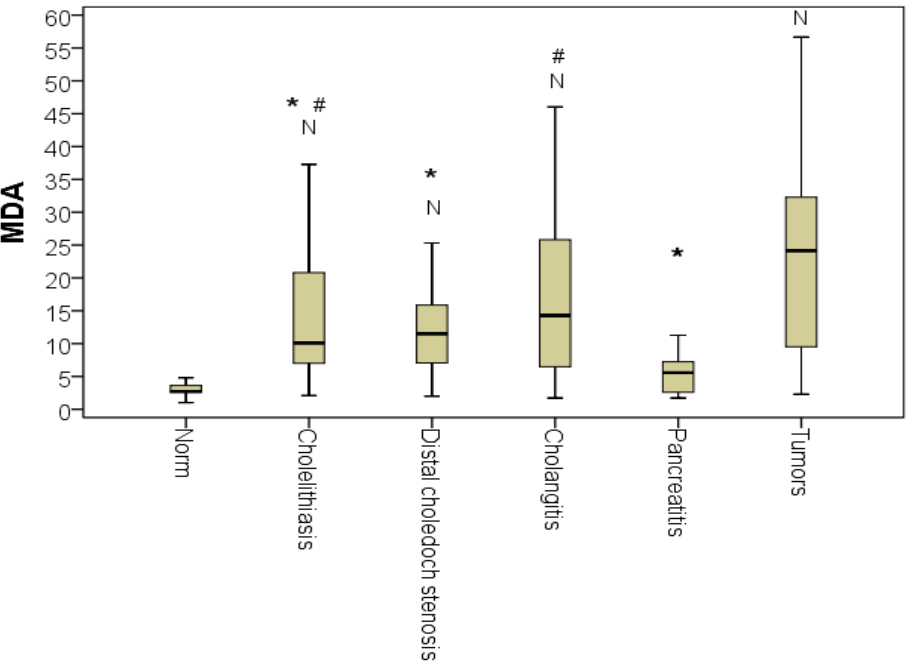
Figure 2. Malondialdehyde (MDA) indicator for different etiologies of jaundice ( n = 128; p < 0.01). * the difference from tumorous jaundice; # the difference from patients with acute pancreatitis; N, the difference from the norm at p < 0.01 (Kruskal-Wallis test).